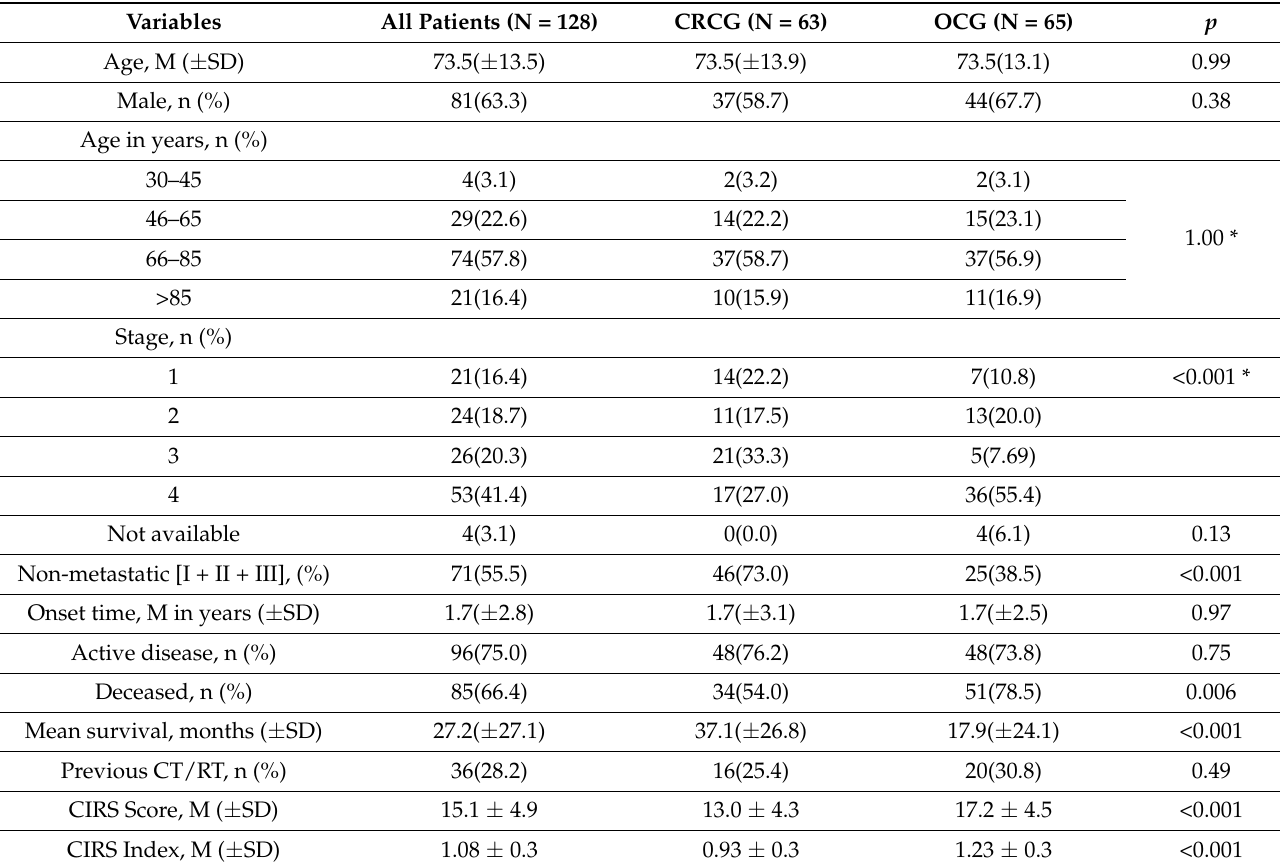
Table 1. Demographic and clinical characteristics of patients. Legend: CIRS, Cumulative Illness Rating Scale; CRCG, colorectal cancer group; M, mean; n, number of patients; OCG, other cancer group; SD, standard deviation. * For age of patients and stage of disease, χ 2 -tests for trend were